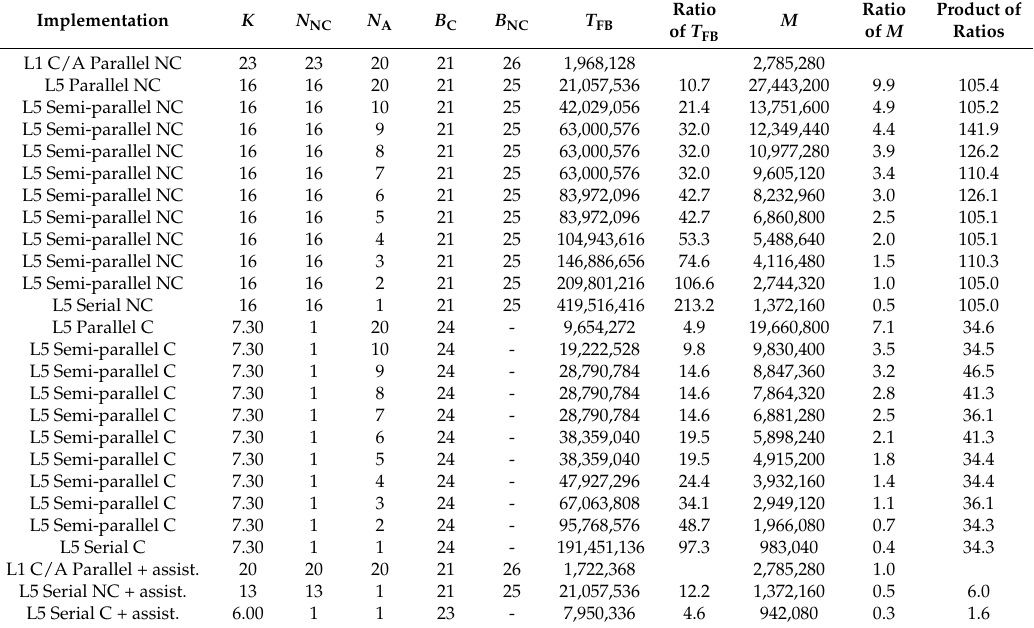
Table 8. Processing time (clock cycle) and memory requirements (bit) of the different implementations for a sensitivity of − 150 dBm with average losses. Ratios are computed with the values of the L1 C/A